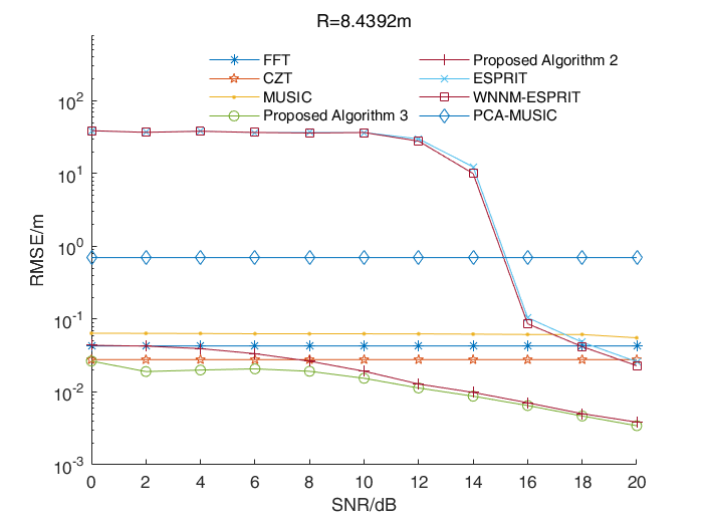
Figure 7. The RMSE values of the distance estimations versus the SNR values of various algorithms when R = 8.4392 m.